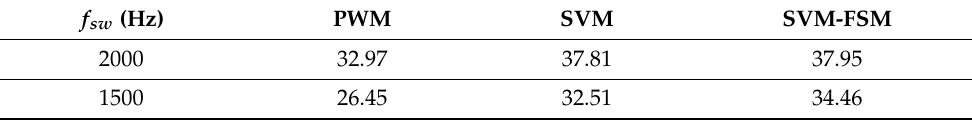
Table 9. Efficiency